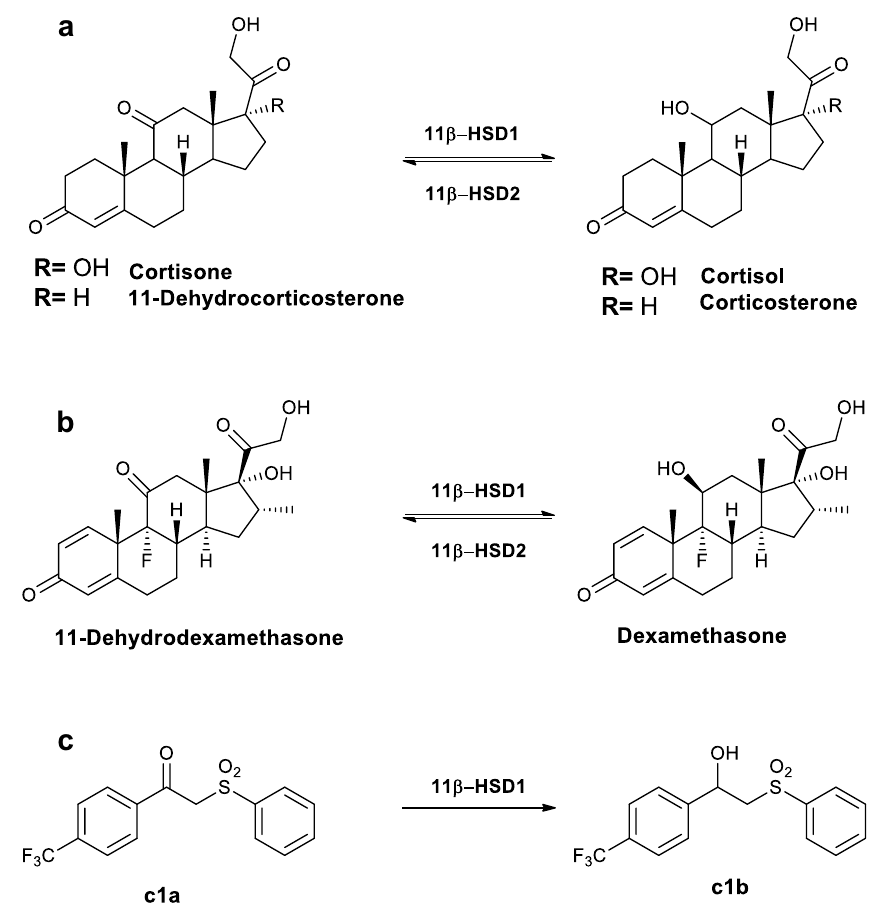
Figure 1. Metabolism of substrates by 11β-hydroxysteroid dehydrogenases. 11β-Hydroxysteroid dehydrogenase (11β-HSD) 1 reduces 11-keto steroids and non-steroidal tracers. (a) 11β-HSD1 converts inactive keto glucocorticoids cortisone or 11-dehydrocorticosterone into active hydroxy glucocorticoids, cortisol or corticosterone, respectively. 11β-HSD2 catalyses the reverse dehydrogenase reactions. (b) 11β-HSD1 and 11β- HSD2 also interconvert synthetic fluorinated steroids, 11-dehydrodexamethasone and dexamethasone. (c) The synthetic non-steroidal fluorinated compound c1a is also a substrate for 11β-HSD1, being converted to c1b